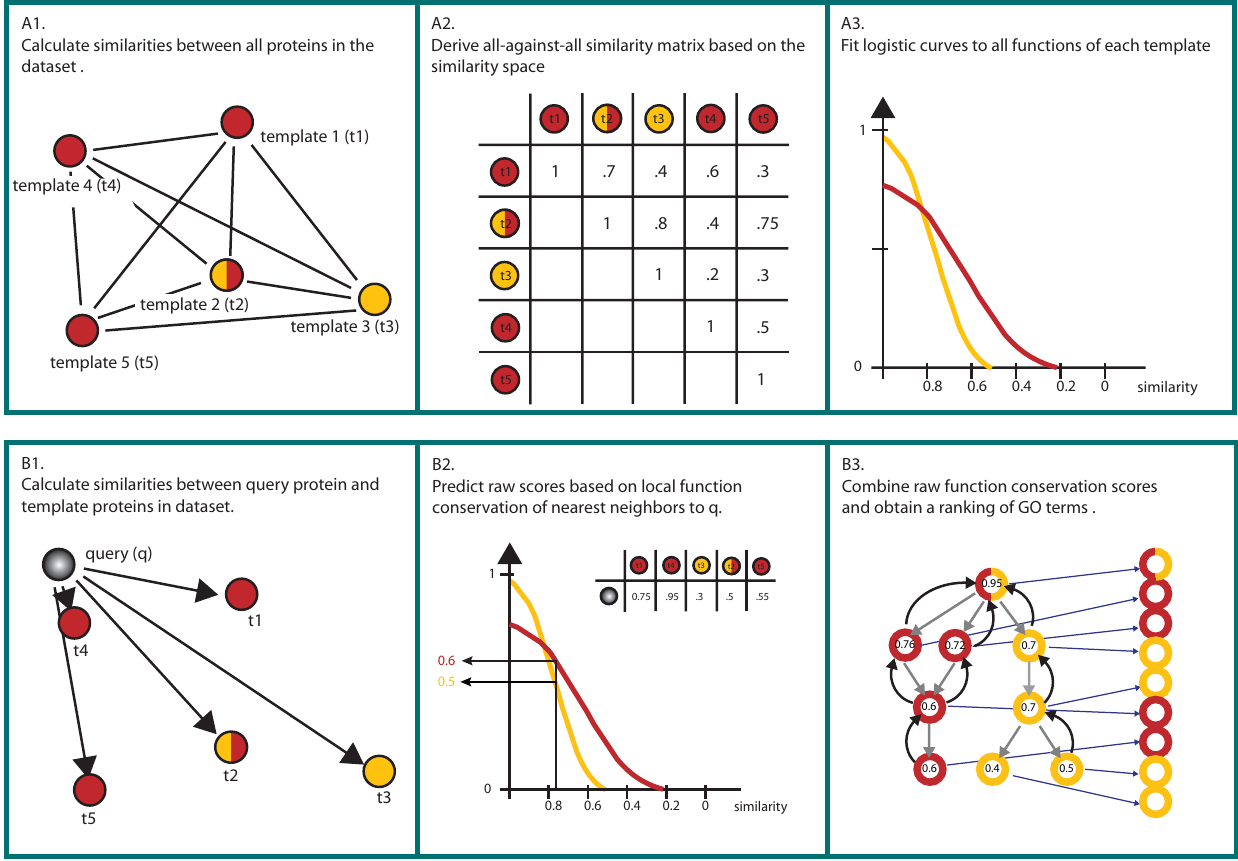
Figure 3. Overview of the GOdot Method. We exemplify the GOdot method on a set of five template proteins (t1–t5) having two different molecular functions (drawn in yellow and red, respectively). The training procedure (top row) consists of similarity calculations (A1), yielding four different similarity matrices one of which is shown (A2). Based on these similarities, logistic curves are fitted for each molecular function in the dataset (A3). The prediction (bottom row) comprises similarity computations between the query protein and the proteins in our dataset (B1), which are then used to predict the conservation of molecular functions in the queries proximity (B2). The final ranking of GO terms is obtained using combination schemes along the GO graph structure (B3). See Methods section for